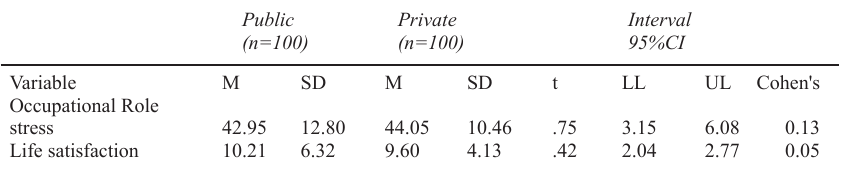
Table 5 Mean, standard deviation, and t values for Gov't and Private Teachers for study variables